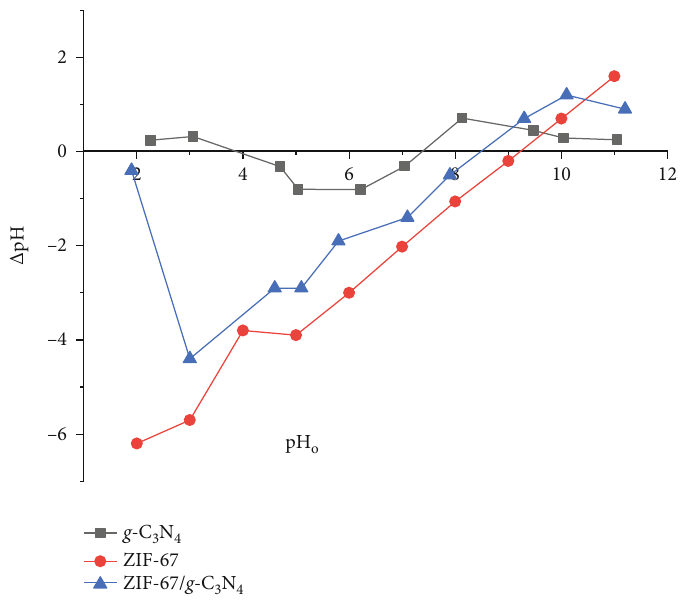
Figure 6: Point of zero charge (pH